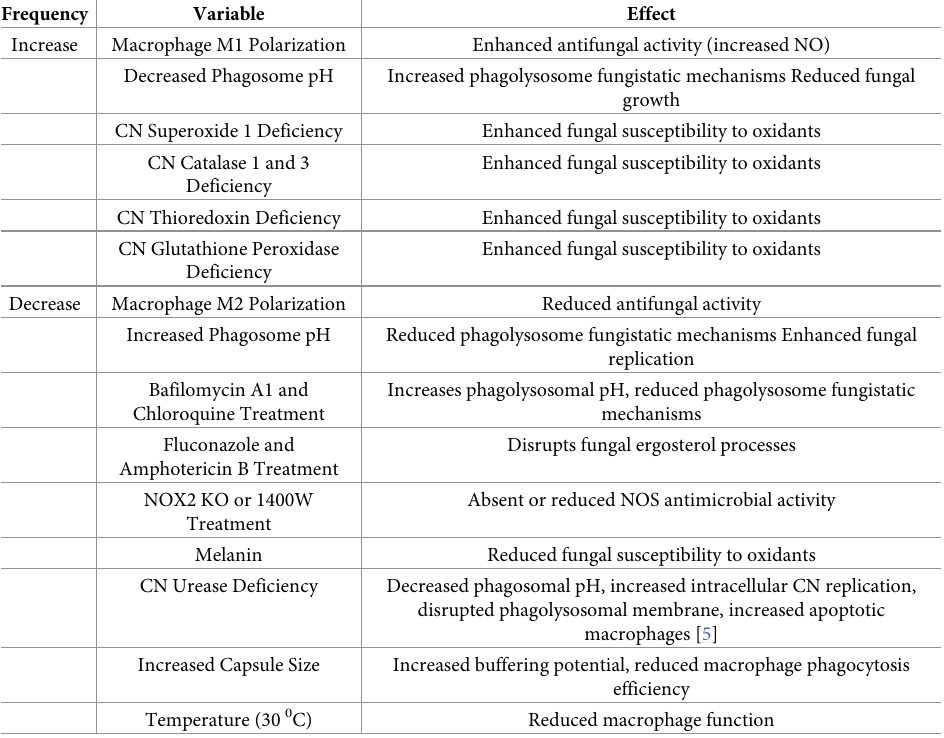
Table 2. Summary of variable effects on Dragotcytosis